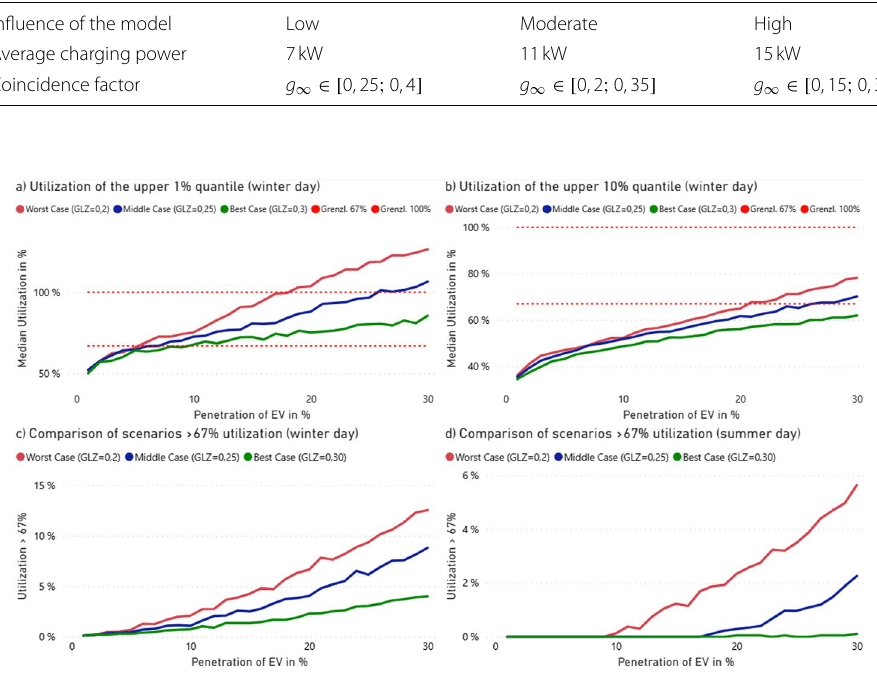
Table 1 Scenarios Scenario Best